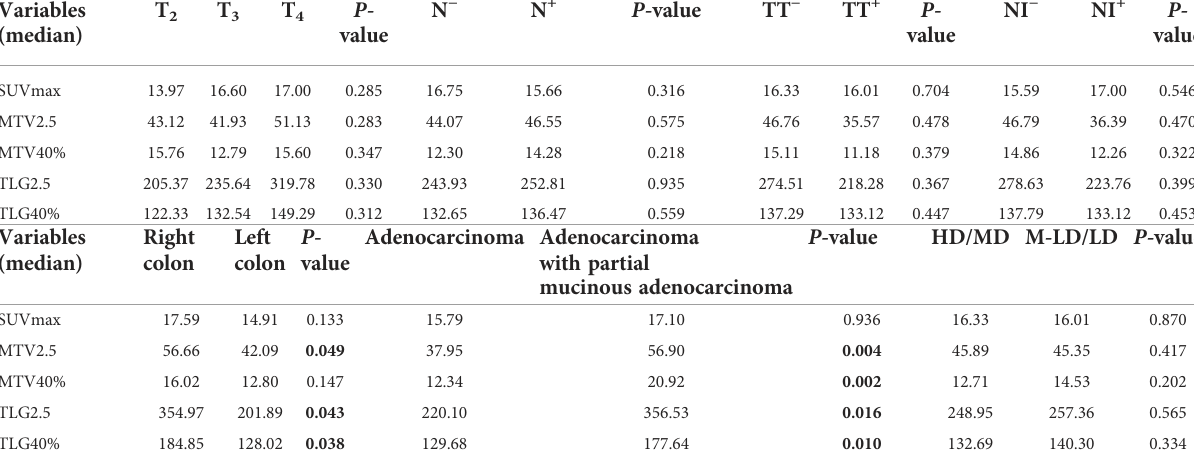
TABLE 2 Differences in 18 F-FDG PET/CT conventional parameters between different pathological features. Variables (median)